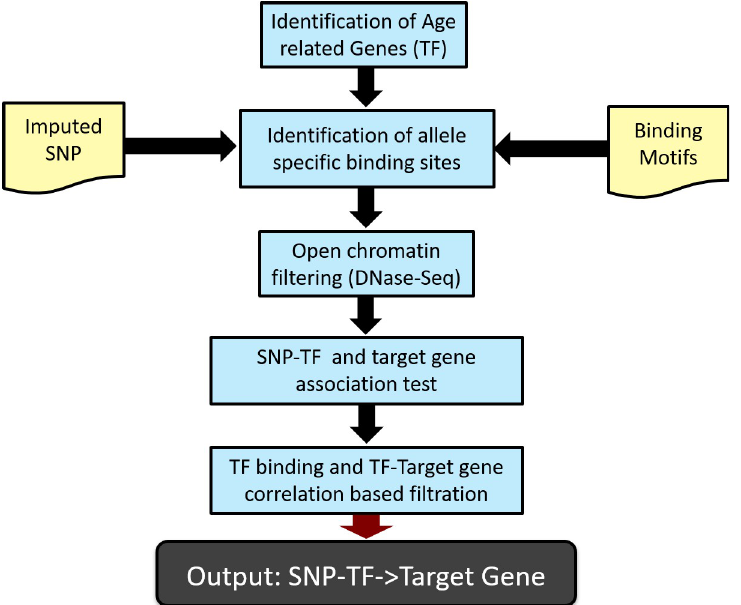
Fig 2. SNiPage pipeline. We identify age-associated TFs, and then identify genome-wide (imputed) SNPs at which those age-associated TFs are predicted to have allele-specific binding, based on their known DNA-binding motifs. The resulting SNPs are filtered to retain only those in open chromatin region, based on tissue-specific DNase-Seq data. Then we test the interaction significance using a linear model, which measures the association between the interaction and target gene expression. Finally, we further select the potential functional interactions based on consistency with allele-specific binding predictions and the TF-target gene expression